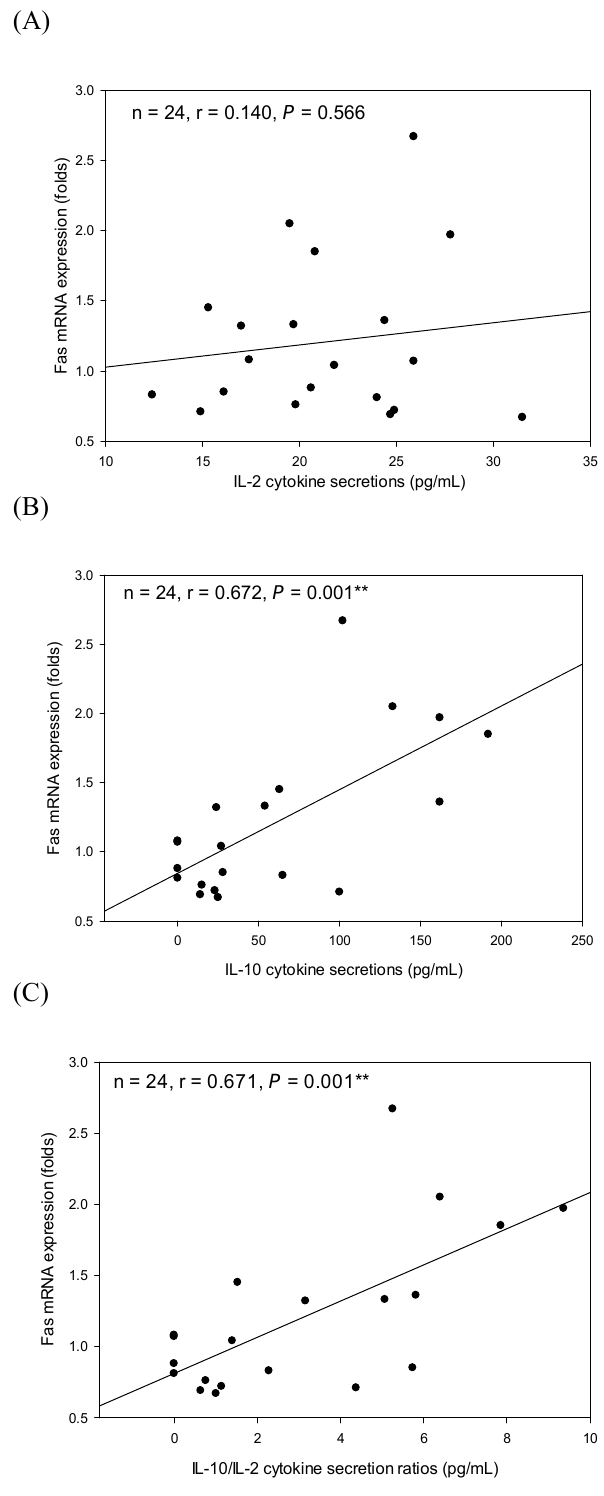
Figure 5. Correlations between IL-2 ( A ), IL-10 ( B ), as well as IL-10/IL-2 ( C ) cytokine secretion profiles in splenocyte conditioned media cultured with GSF3 (SGSF3) and Fas mRNA expression amounts in the corresponding treated PC-3 cells. The correlation was expressed by Pearson product-moment correlation coefficient (r). The correlation is considered statistically different if p < 0.05. **, p <